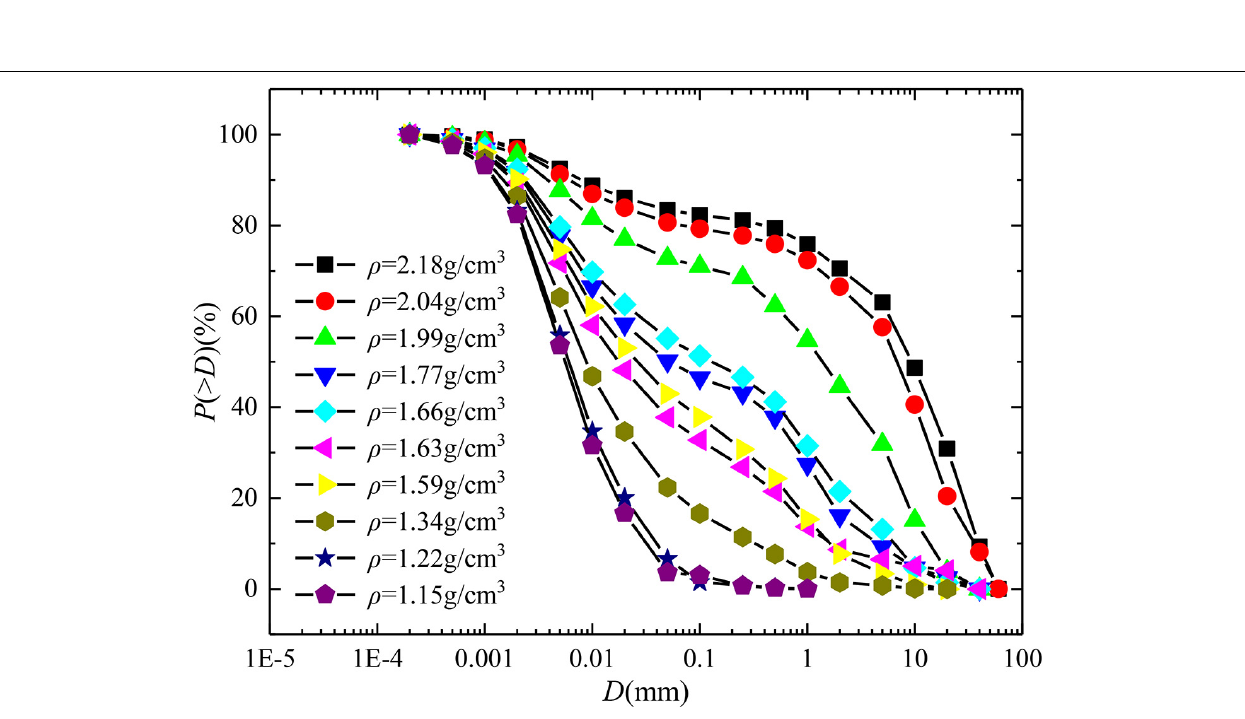
FIGURE 4 | GSD curves of debris flow at different